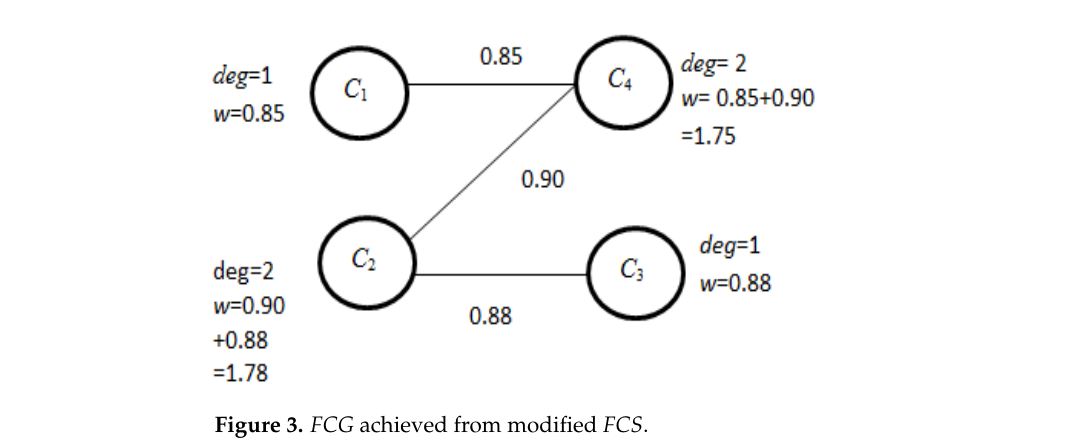
Figure 3. FCG achieved from modified FCS.